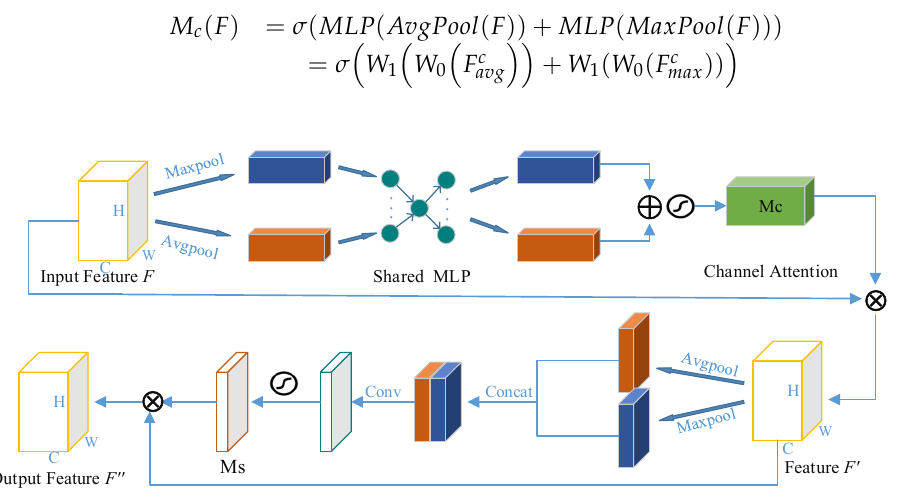
Figure 4. Convolutional block attention module.